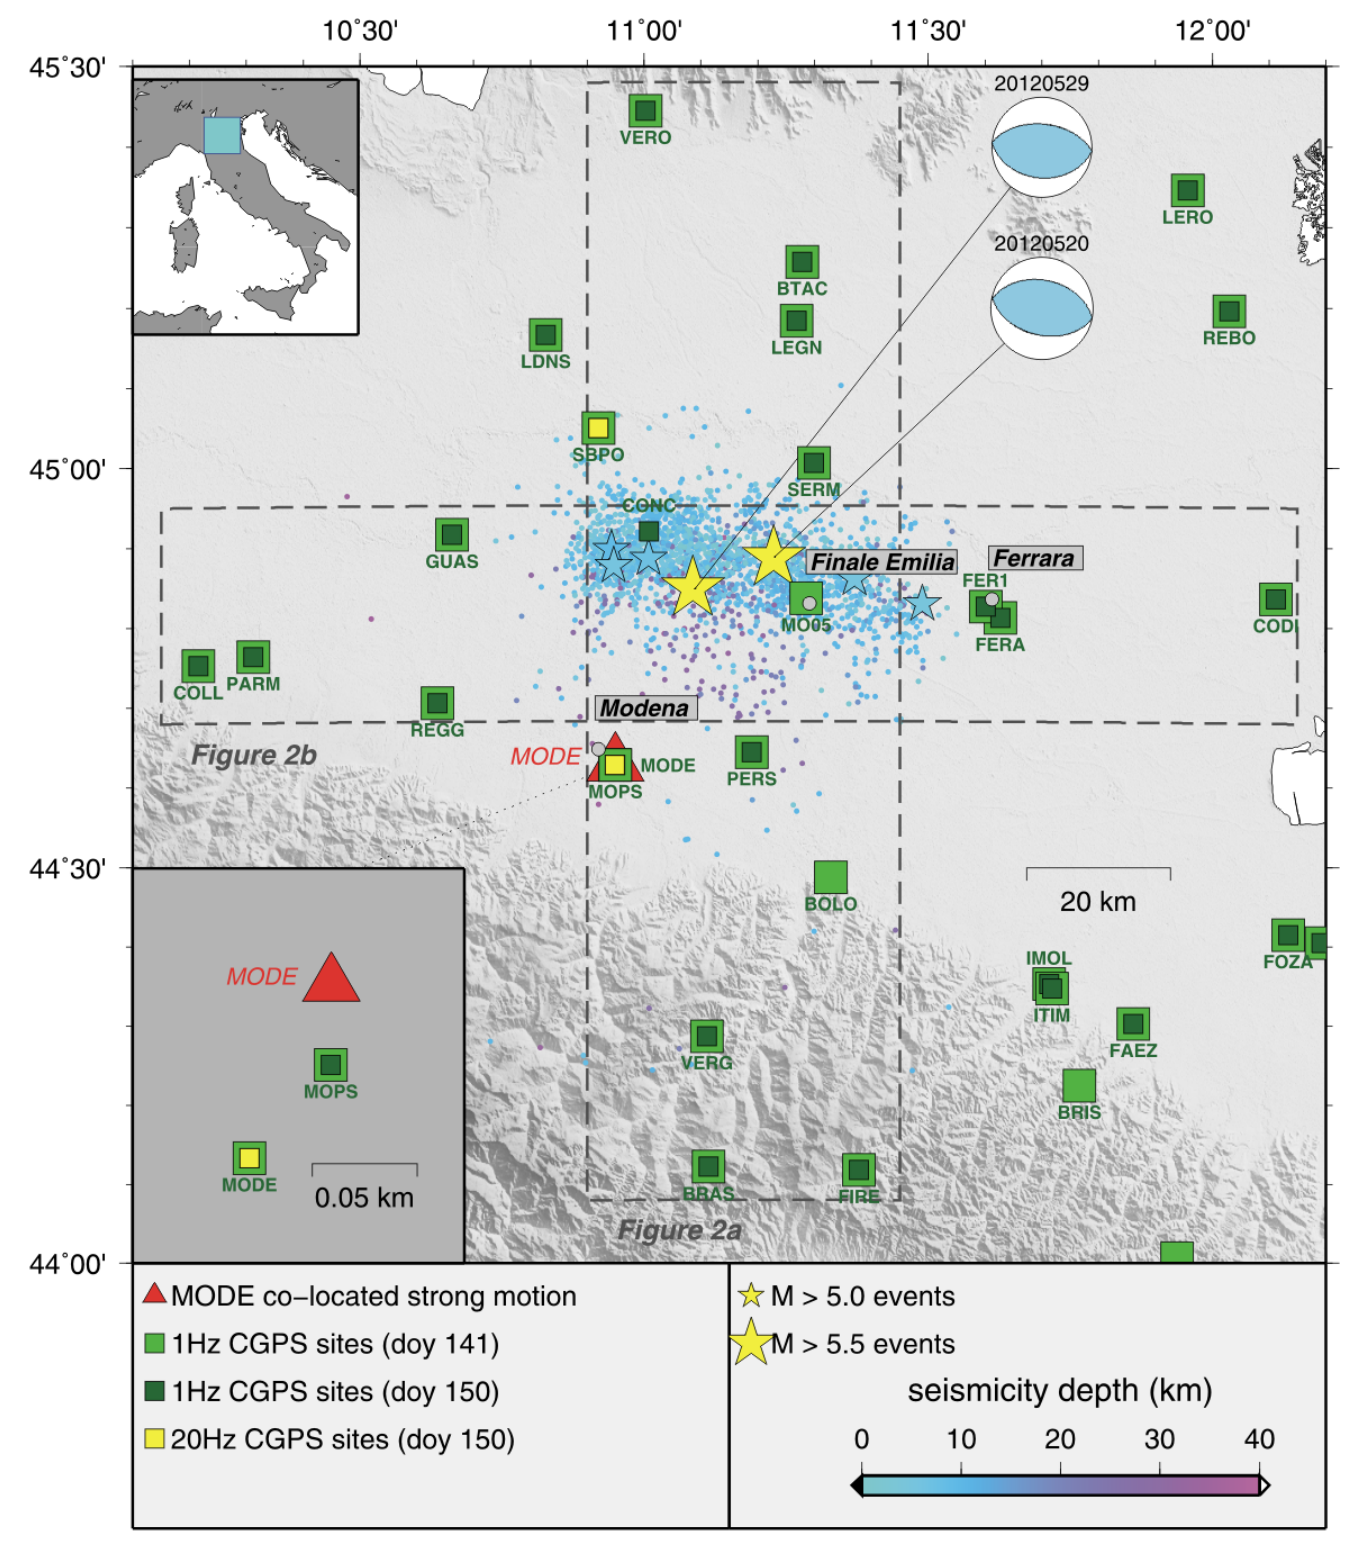
Figure 1. Locations of the high-rate (1 Hz and 20 Hz) cGPS stations operating during the Emilia-Romagna 2012 seismic sequence (squares). Red trian- gle, co-located strong-motion station of MODE; dashed boxes, N-S and W-E profiles of the coseismic displacements of Figure 2A, B. The two largest events (yellow stars), their focal mechanisms (beach balls), and the spatial distribution of the ca. 2300 events aftershocks (dots) are shown, as updated to July 20, 2012 (data from http://iside.rm.ingv.it and described in Scognamiglio et al. [2012]). The color scale indicates the depths of the